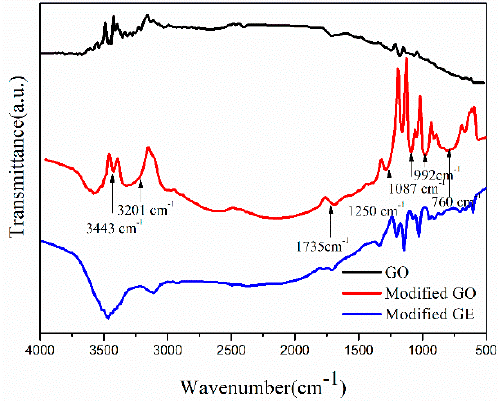
Figure 1. FTIR spectra of GO, modified GO, and modified GE.